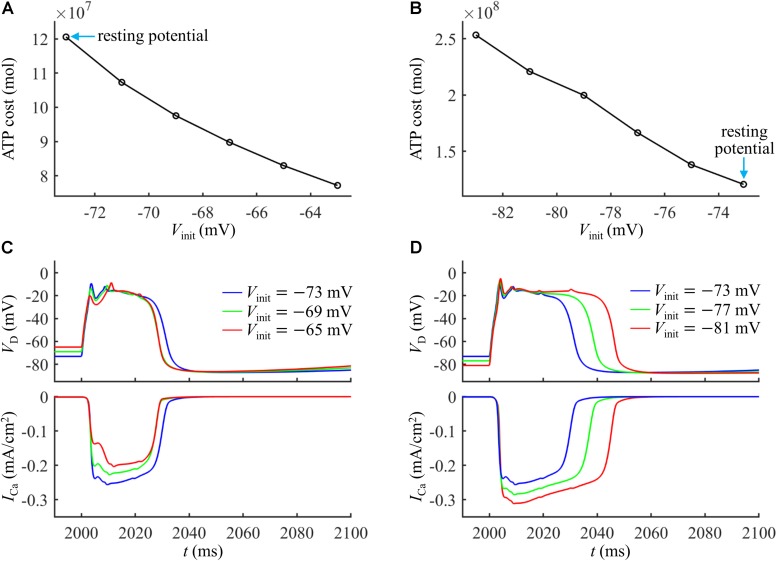
(A) Ca2+ spike cost in the active dendrite as a function of depolarizing Vinit. (B) Ca2+ spike cost in the active dendrite as a function of hyperpolarizing Vinit. (C) Time courses of VD and underlying ICa recorded at Vinit = –65, –69, and –73 mV. (D) Time courses of VD and underlying ICa recorded at Vinit = –81, –77, and –73 mV. A constant current of 1000 ms was injected to generate different values of Vinit in the active dendrite. At the end of constant stimulus, a synaptic current Isyn was injected to stimulate a Ca2+ spike. The injection site of constant and synaptic currents was indicated by a red triangle in Figure 1A. Isyn = 2.3Ith and IS = 0 nA.